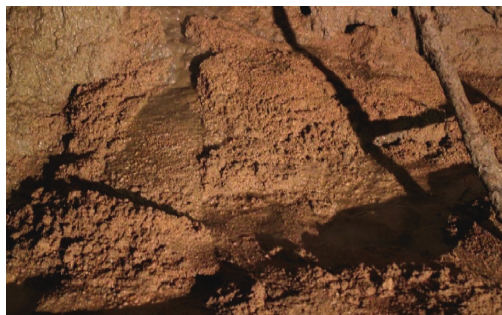
Figure 3: Photo of clayey sand in